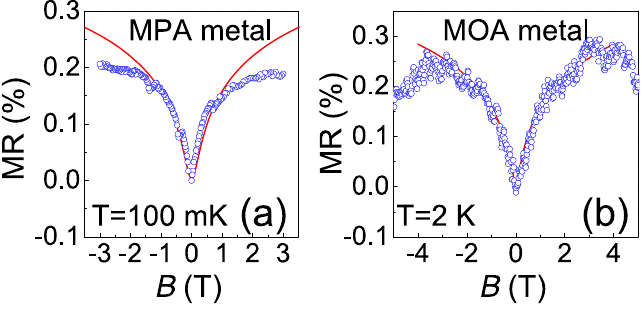
Figure 5. Positive MR in metallic devices. ( a ) an MPA metallic device in the parallel field at T ~ 100 mK; ( b ) an MOA metallic device in the perpendicular field at T = 2 K. Red curves are fitting results by using Equations (11) and (12).